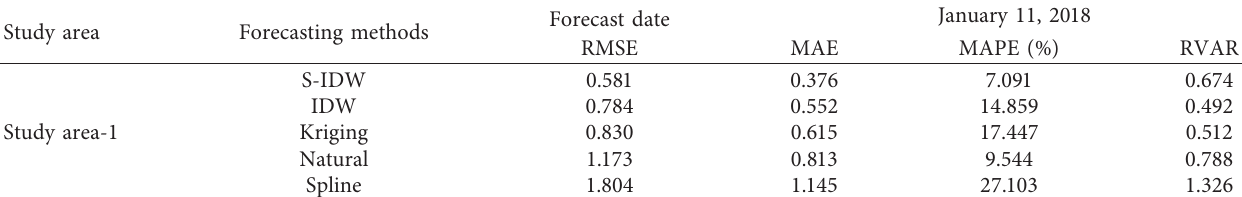
Table 4: Comparison of interpolation accuracy of 5 kinds of interpolation methods on Jan. 11,